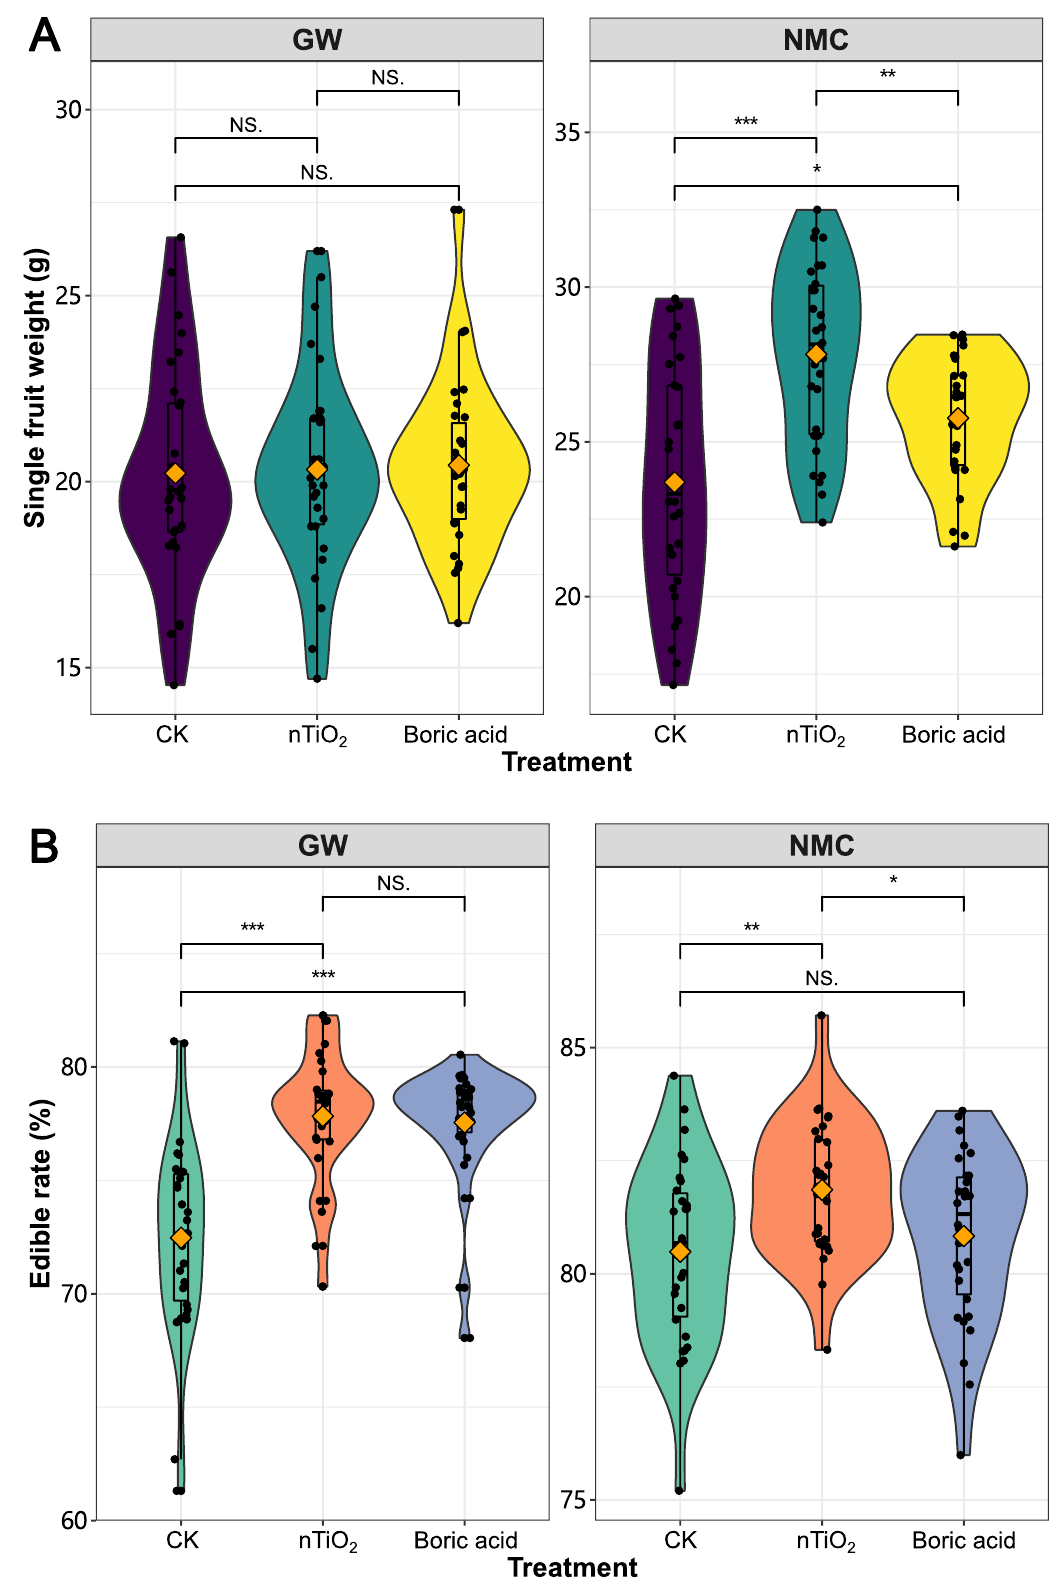
Figure 4. The effect of nTiO 2 and boric acid on single fruit weight and edible rate of litchi. GW: litchi cultivar ‘Guiwei’. NMC: litchi cultivar ‘Nuomici’. NS, no significance differences; *, p ≤ 0.05; **, p ≤ 0.01; ***, p ≤